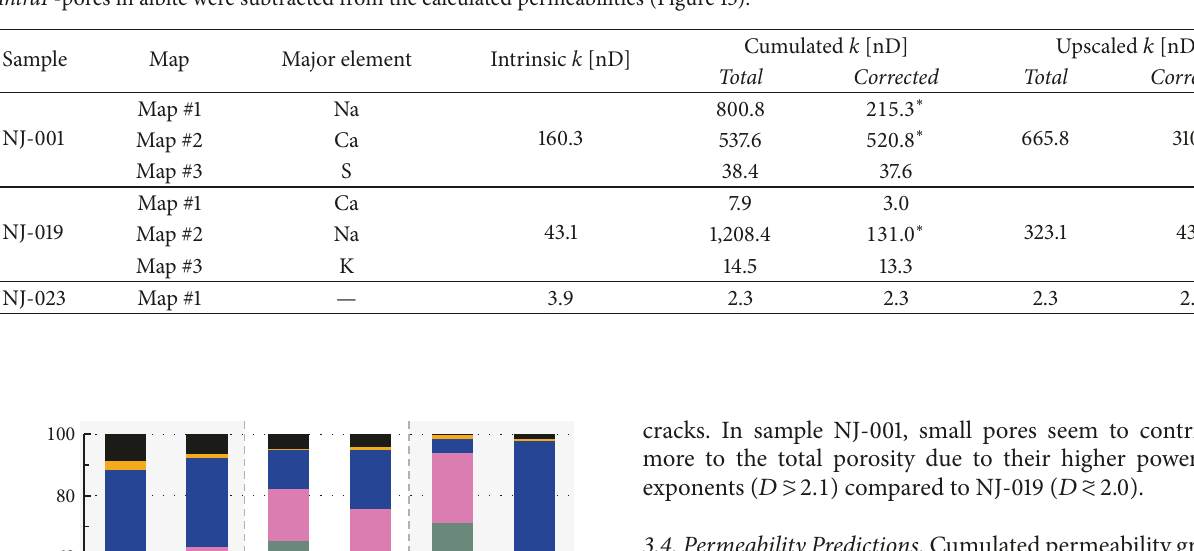
Table 5: Experimental permeabilities (intrinsic) as well as modeled permeabilities (cumulated and upscaled, resp.). Cumulated values show the modeled permeability of each mosaic map derived from the CTM. Upscaled values were normalized (weighted average) to characteristic layer proportions of a whole plug surface (Figure 8). Total includes every visible pore, while corrected only accounts for pores above the PPR and excludes microcracks as well as IntraP -pores in albite in some maps. Marked values ( ∗ ) feature these maps where relatively large IntraP -pores in albite were subtracted from the calculated permeabilities (Figure 13).